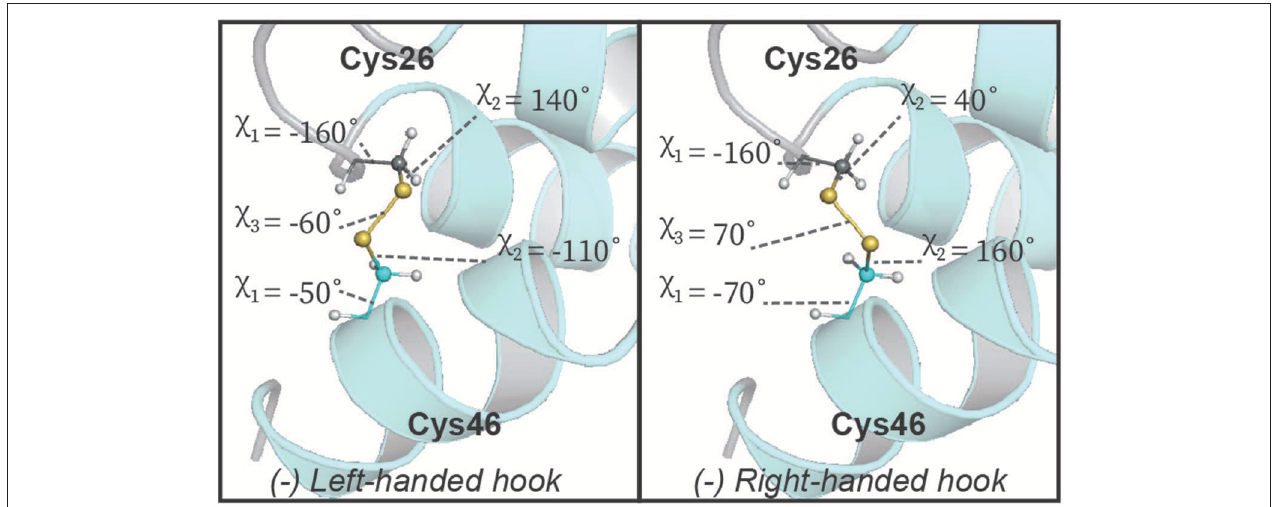
FIGURE 6 | Alternative geometry of the central disulfide bond in Ta1a. The lowest energy structures describing Ta1a all have the same (left-handed hook) conformation. However, some of the higher energy solutions display a right-handed hook conformation which does not violate the dihedral angle restraints used ( χ 1 ). This alternative orientation also retains all C-H and C-C vectors in the disulfide bond in similar positions, suggesting that this type of heterogeneity is unlikely to be resolved by currently available NMR measurements.